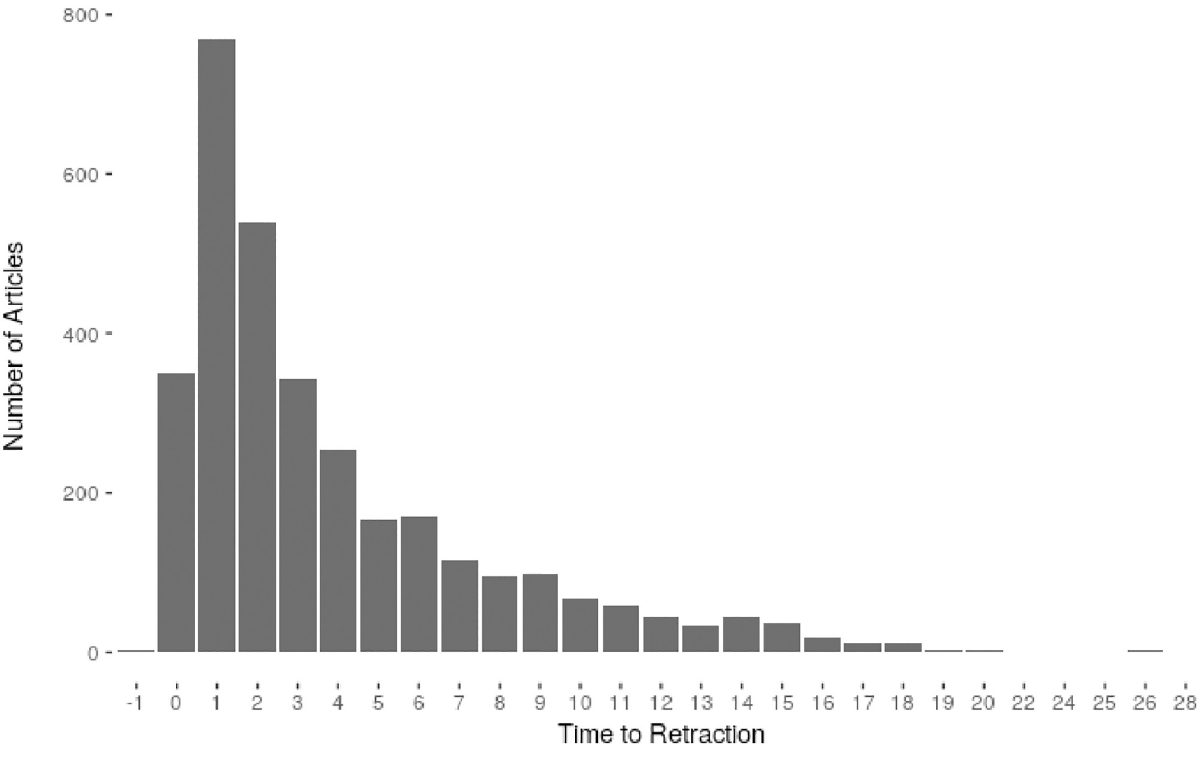
Fig 3. Time lag between publication and